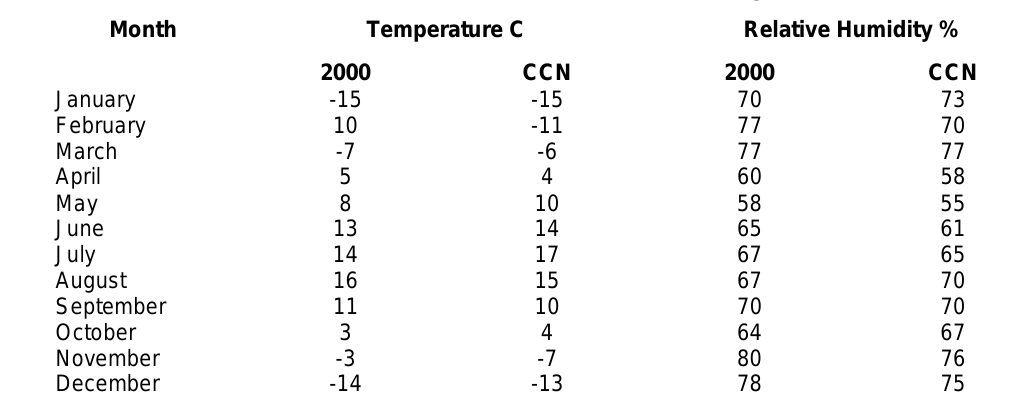
Comparison of Monthly Temperature and Relative Humidity in Fort. St. John Canada